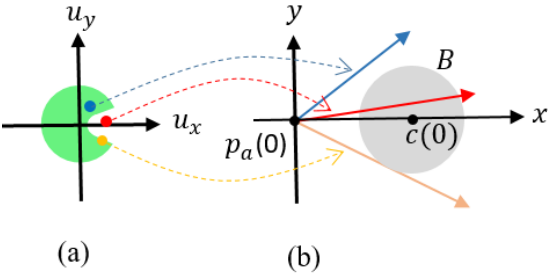
Figure 3. The green region in ( a ) is a safe control space U τ = 5 obtained by taking the complement safe of control obstacle UO τ = 5 in U ad . In ( b ), the paths undertaken by a robot for selected control inputs in U τ = 5 are shown. The velocity in red lies is in control obstacle and its associated path leads robot safe to penetrate into obstacle within 5 s. Velocity in yellow lies on the boundary of control obstacle thus, have margin zero. It leads the robot to graze the obstacle within 5 s. Velocity in blue has margin greater than zero and it leads the robot to navigate from a distance to the